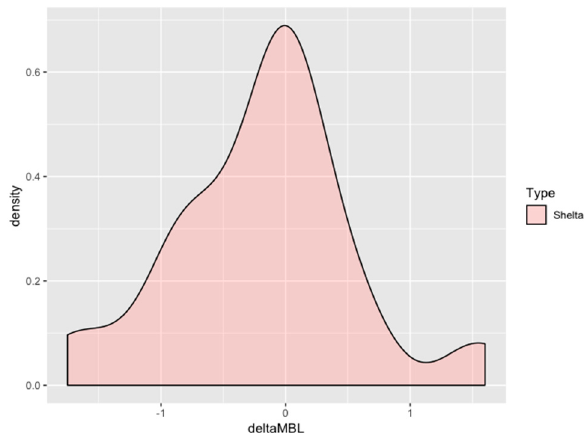
Figure 4. Density plot of the mean marginal bone change frequency distribution one year after loading in the entire cohort. The plot exquisitely shows a bell-shaped curve denoting a predictable amount of marginal bone resorption for the implant-abutment studied: most of the observations converged around zero.